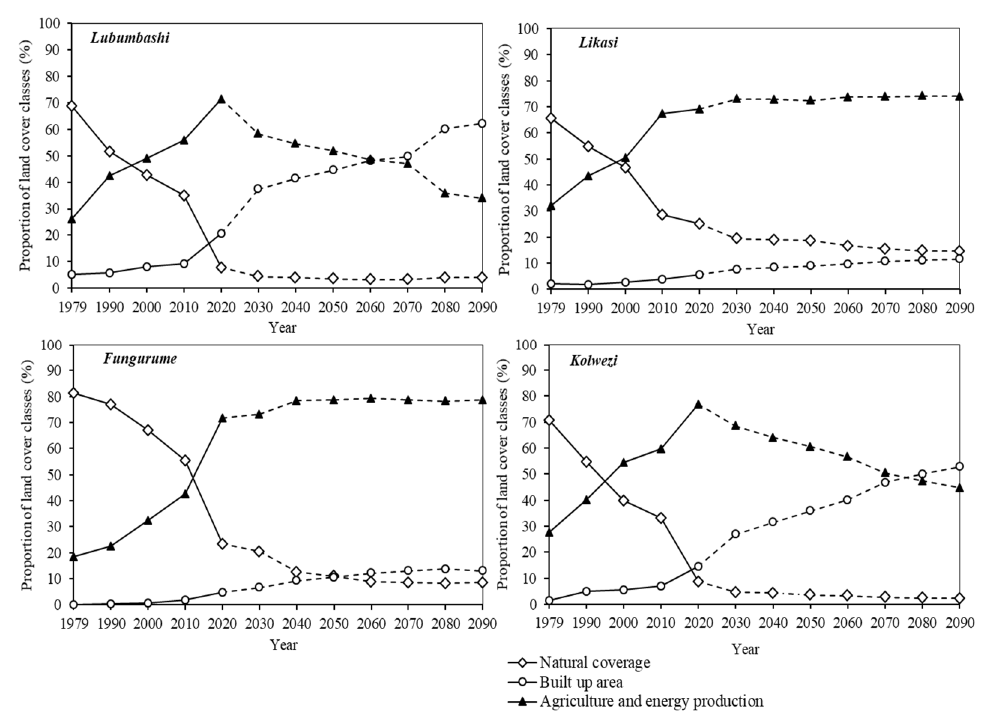
Figure 4. Evolution of the total area of the occupation classes between 1979 and 2090 (total value of each anthropization pole = 1963.5 km 2 ) in the Lubumbashi, Likasi, Fungurume and Kolwezi areas.